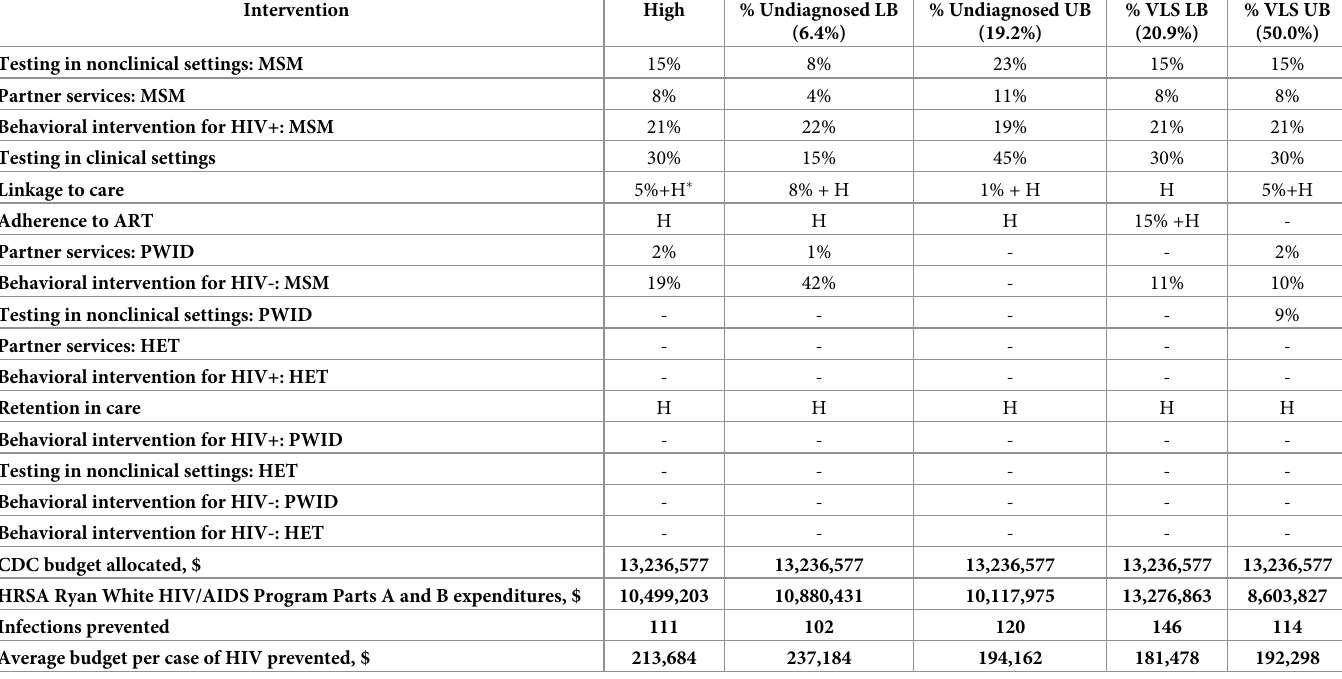
Table 6. Optimal CDC HIV prevention funding allocation: Varying the proportion of PLWH who are diagnosed with HIV and who have achieved viral load sup- pression (VLS) in the high health department group.